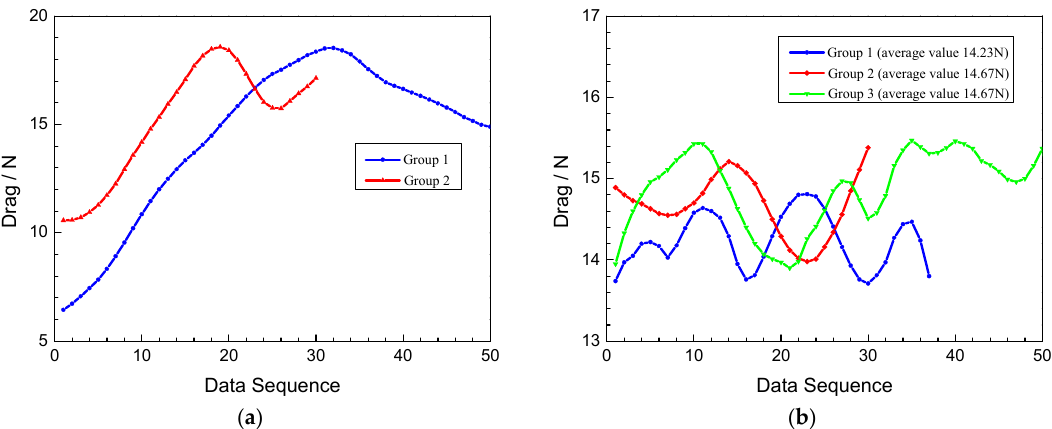
Figure 11. Local drag test results of the cement column in the rubber cylinder: ( a ) A typical drag curve at the early test stage; and ( b ) typical drag curves at the stable stage.